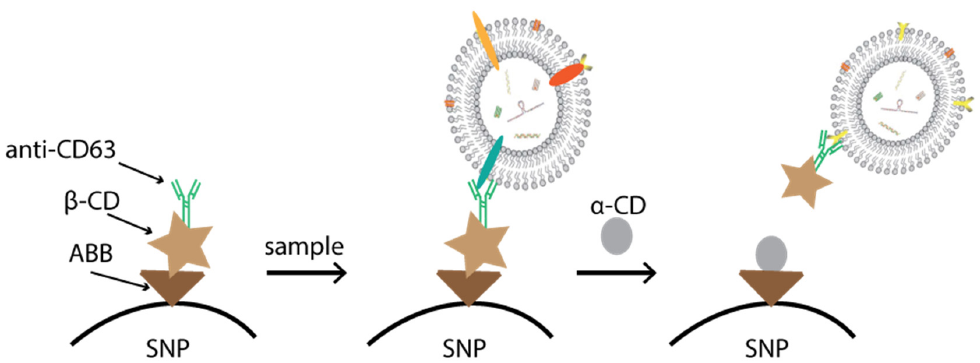
Figure 2. Schematic diagram for EV capture and release through the host guest interactions between β -cyclodextrin ( β -CD) and 4-aminoazobenzene (AAB). The immunoaffinitive superparamagnetic nanoparticles (SNPs) are prepared by modification with AAB and then connection to β -CD-PEG 2000 - COOH. EVs in different samples are captured by immunoaffinitive SNPs and mildly eluted by adding the competitive host molecule, α -CD.